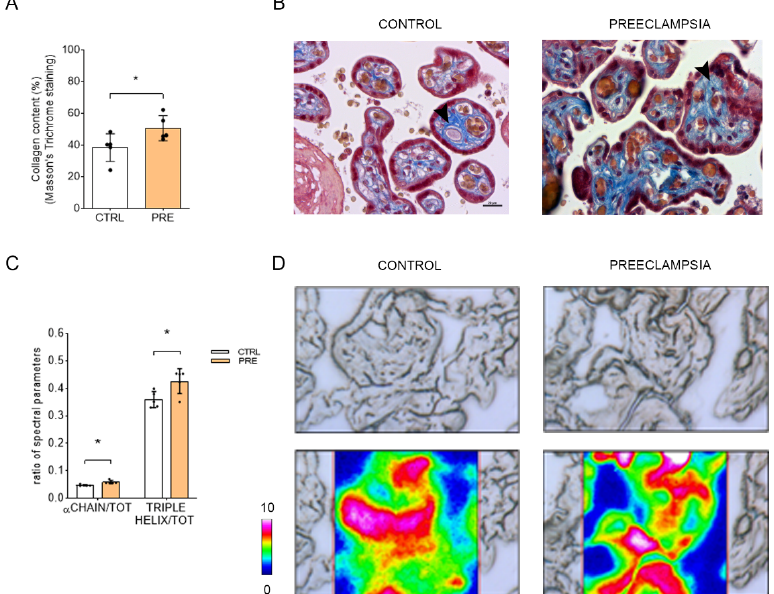
Figure 5. Histological and FTIRI analysis of collagen in the two experimental groups. Analysis of collagen deposition in CV sections using Masson’s trichrome staining ( A , B ). Bars represent collagen content in the two conditions expressed as mean ± SD of five independent samples ( n = 5). Histological images show the collagen stained in blue (arrowhead) inside the CV stroma. Analysis of collagen deposition in CV section by means of FTIRI ( C , D ). Bars represent the ratio of the following spectral parameters: α chain/TOT, relative amount of α chain secondary structures in collagen; Triple helix/TOT, relative amount of triple helix structures in collagen. Results are reported as mean ± SD of five independent samples ( n = 5), and asterisks indicate significant differences between CTRL and PRE groups (* = p < 0.05). In false color images, the topographical distribution of protein within the mapped area in the Amide III was reported with absorbances ranging from pink representing the highest absorbance and blue representing the lowest absorbance.